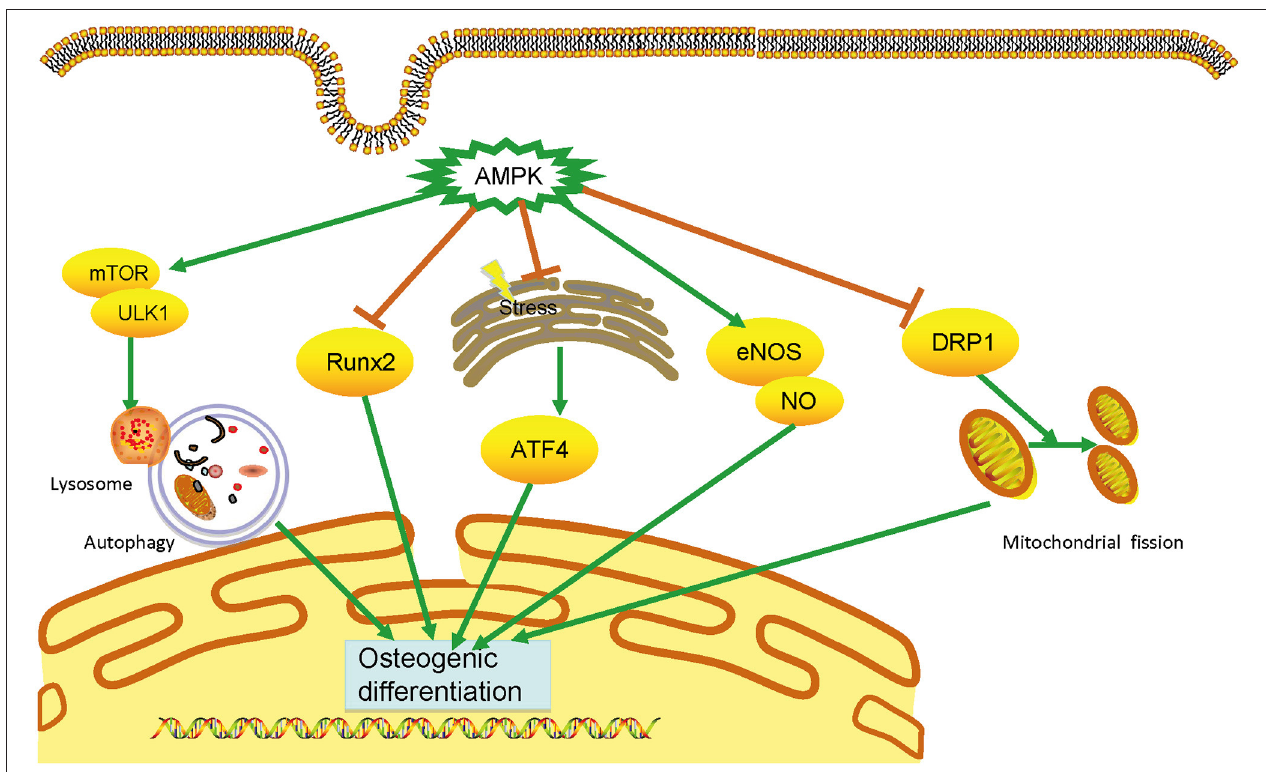
FIGURE 1 | Mechanisms of AMPK in vascular calcification. AMPK plays an essential role in calcification through multiple mechanisms, including inhibiting runt-related transcription factor 2 (Runx2) signaling pathways, triggering autophagy, attenuating endoplasmic reticulum stress, and dynamic-related protein 1(DRP1)-mediated mitochondrial fission, and activating endothelial nitric oxide synthase. By preventing the osteogenic differentiation of vascular smooth muscle cells, AMPK can prevent vascular calcification development. AMPK, AMP-activated protein kinase; DRP1, dynamic-related protein 1; eNOS, endothelial nitric oxide synthase; ERS, endoplasmic reticulum stress; VSMC, vascular smooth muscle